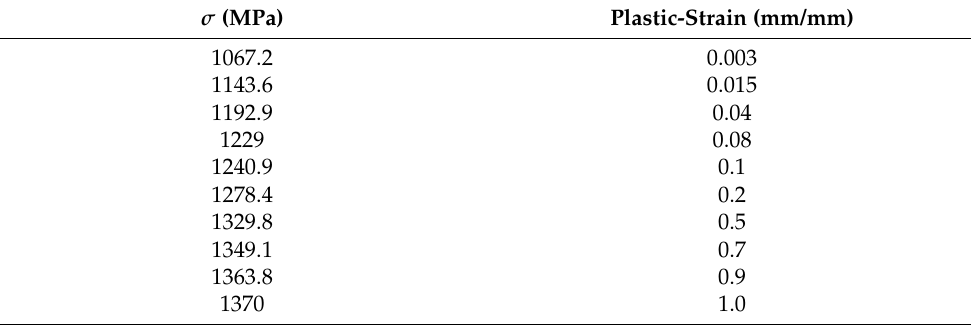
Table 2. Experimental true stress- plastic strain data for ABAQUS input analysis.